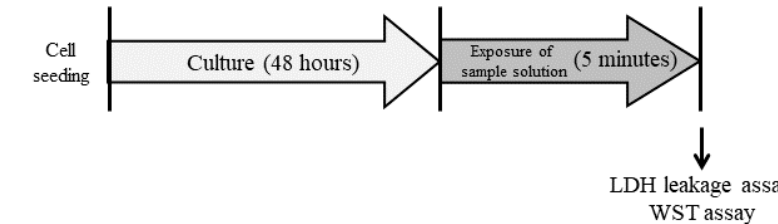
Figure 9. Cytotoxicity test for the NHEK-Ad cells. NHEK-Ad cells that had been cultured in KBM-Gold medium for 48 h were treated with 100 mL/well of each sample for 5 min. The solution was collected from each well and used for the LDH leakage assay. After that, their viability was assessed.